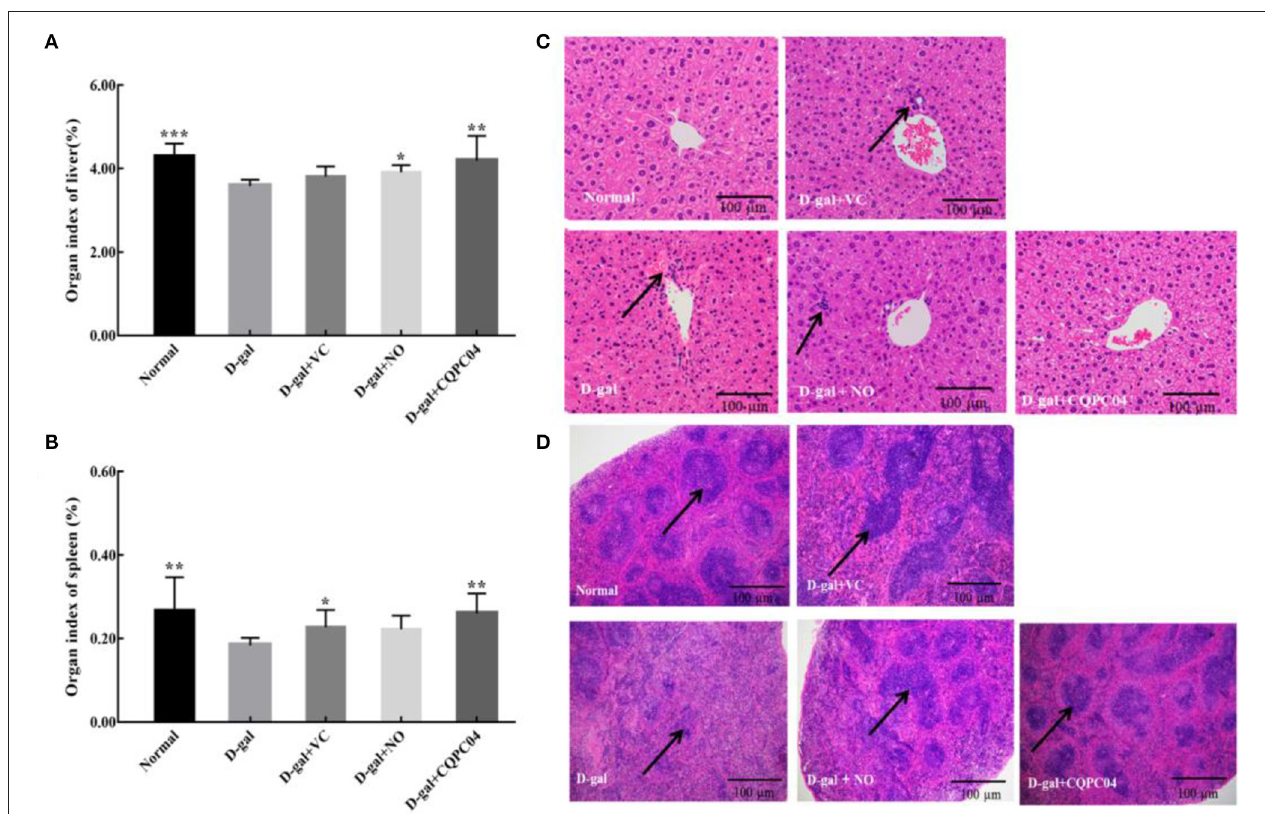
FIGURE 3 | Organ index and pathological observation of liver and spleen. (A) organ index of liver; (B) organ index of spleen; (C) pathological observation of liver; (D) pathological observation of spleen. D-gal: mice fed the standard chow diet plus drinking water with intraperitoneal injection of D-galactose (120 mg/kg of BW); D-gal + VC: vitamin C (100 mg/kg of BW) plus intraperitoneal injection of D-galactose (120 mg/kg of BW); D-gal + NO: non-fermented soy milk (0.1 mL/10g of BW) plus intraperitoneal injection of D-galactose (120 mg/kg of BW); D-gal + CQPC04: L. fermentum CQPC04-fermented soy milk (0.1 mL/10g of BW) plus intraperitoneal injection of D-galactose (120 mg/kg of BW). * p < 0.05, ** p < 0.01, and *** p < 0.001 compared to D-gal group. (C) the black arrows indicate necrotic cells, and the black bar represents 100 µ m. (D) the black arrows indicate white pulp, the black bar represents 100 µ